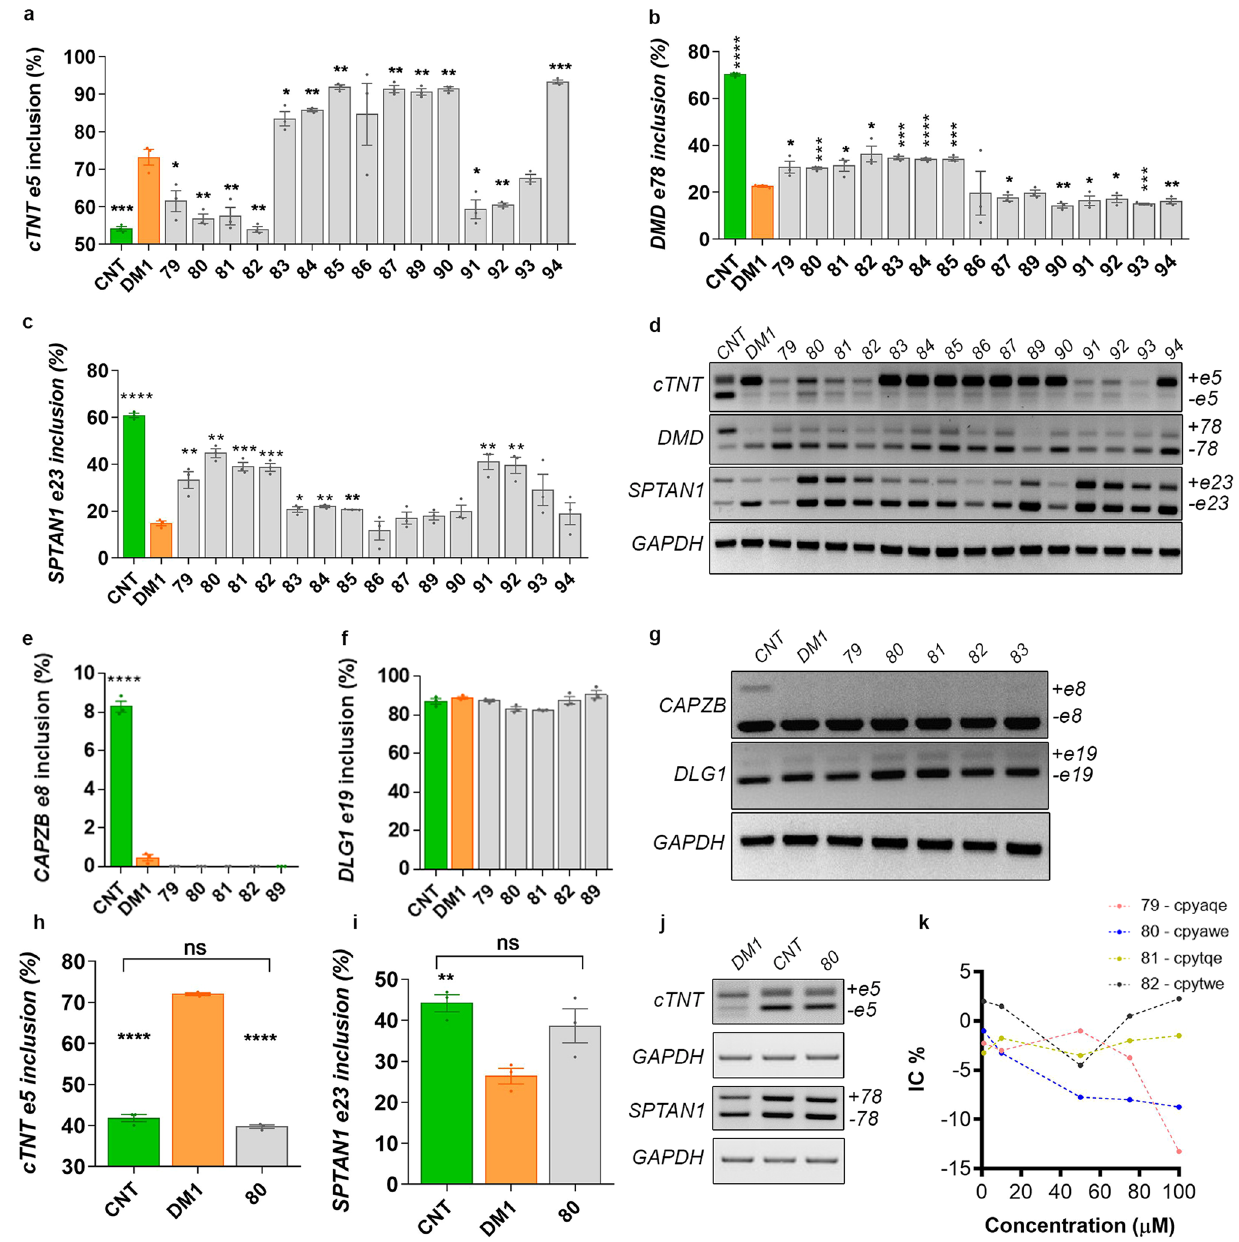
Figure 1. Peptides 79, 80, 81, and 82 rescued MBNL-dependent mis-splicing events in DM1 myotubes. Control (CNT, with no DMSO) and DM1 myotubes (96 h of differentiation, 3 biological replicates of each condition) were treated with 10 μM of the indicated peptides or DMSO (0.1%) for 48 h and the percentage of inclusion of cTNT exon 5 ( a ), DMD exon 78 ( b ), and SPTAN1 exon 23 ( c ) was determined. ( d ) Representative 2% agarose gels showing semiquantitative RT-PCR amplicons with or without the indicated exons and GAPDH internal control. None of the tested peptides induced changes in the splicing of the CAPZB gene, altered in DM1 and regulated by the CELF1 protein ( e , g ) or in the splicing of the DLG1 gene, which remains unchanged in DM1 ( f , g ). The inclusion of exon 5 of the cTNT gene, regulated by MBNL1, ( h , j ) and the inclusion of the exon 23 of the gene SPTAN1, regulated by MBNL2 ( i , j ), did not respond to peptide 80 in CNT myotubes, thus supporting the specificity of its activity. Cell growth inhibition assay by MTS method. Human CNT myotubes were transfected with increasing concentrations of the indicated peptides (4 biological replicates per condition) ( k ). *p < 0.05, **p < 0.01, ***p < 0.001, ****p < 0.0001, ns p > 0.05 according to Student’s